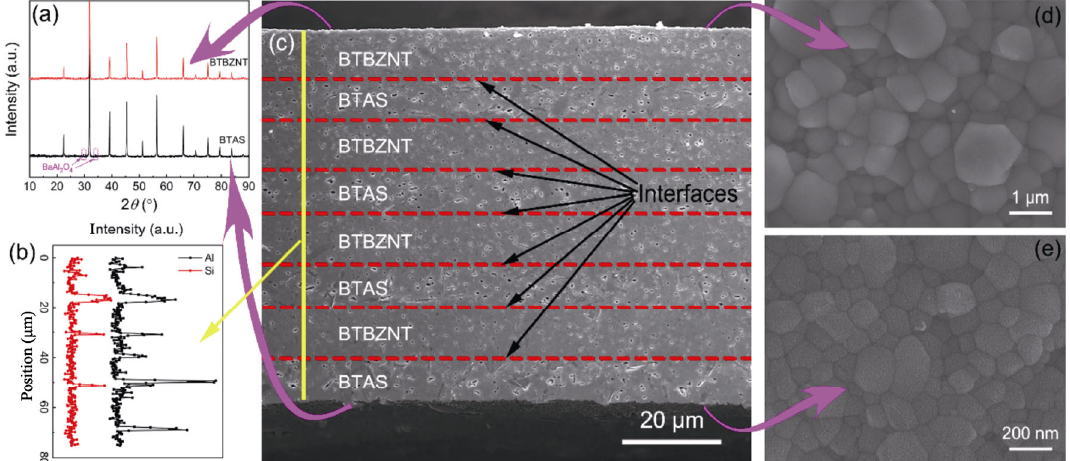
Fig. 21 Microstructure characterization of the layer-by-layer ceramics with four BTBZNT layers and four BTAS layers alternately arranged in parallel. The cross-section SEM image is shown in the middle (c), in which the BTBZNT layers, BTAS layers, and the interfaces can be clearly identified. The results can be further confirmed via line scanning of the Al and Si elements in (b). The XRD patterns and surface SEM images of each end of the BTBZNT and BTAS layers are presented in (a), (d), and (e), respectively. Reproduced with permission from Ref. [114], © The Royal Society of Chemistry 2019. BTAS layer (~100